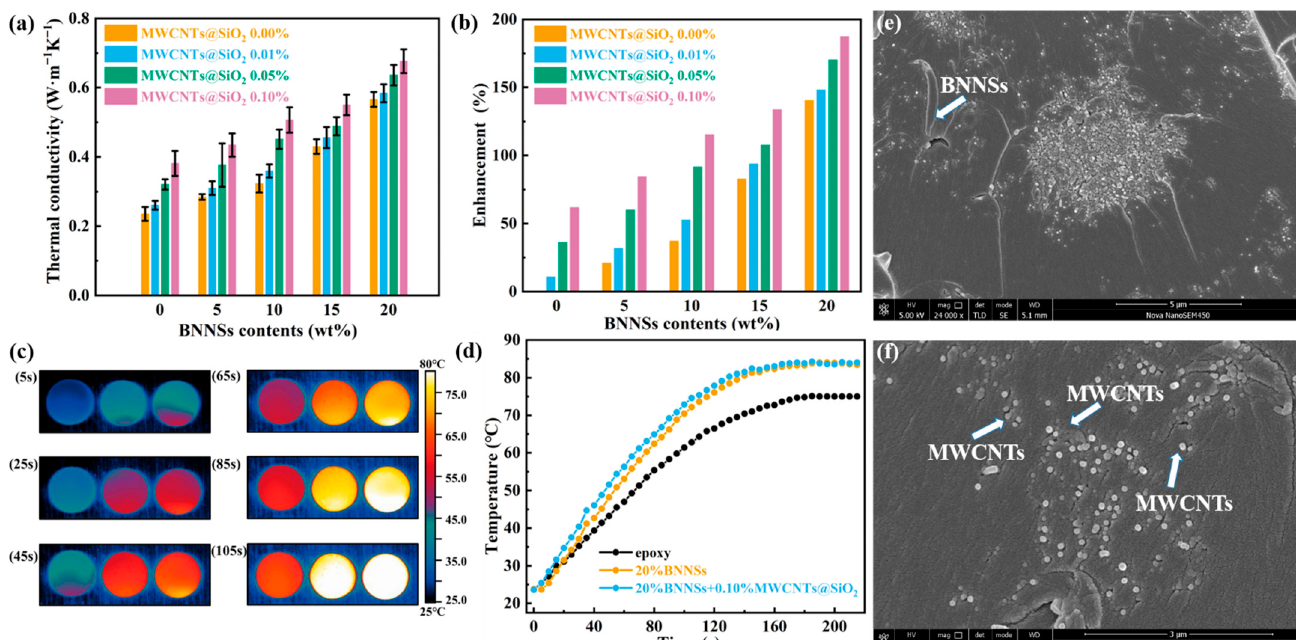
Figure 3. ( a ) Thermal conductivities of composites. ( b ) Enhancement efficiency of composites. ( c ) Infrared thermal imaging of composites; epoxy (left), BNNSs/epoxy (middle), BNNSs/MWCNTs@mSiO 2 /epoxy (right) ( d ) Curves of composites surface temperature as a function of time. ( e , f ) The cryogenically fractured surfaces morphologies SEM images of the BNNSs/MWCNTs@mSiO 2 /epoxy composites at different magnification.